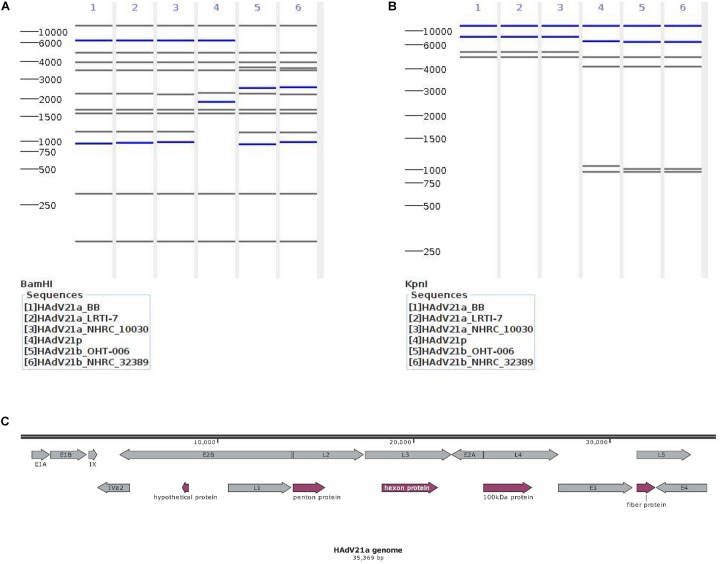
Genomic characterization of the current isolate. (A,B) Genome type analysis using restriction enzyme BamHI (A) and KpnI (B). The numbers on the far left denote the molecular weight markers (bp). (C) Genomic annotation of the current isolate. Genes were displayed in gray, and CDSs discussed below in plum. “100 KDa protein” indicates the 100 kDa hexon-assembly associated protein.